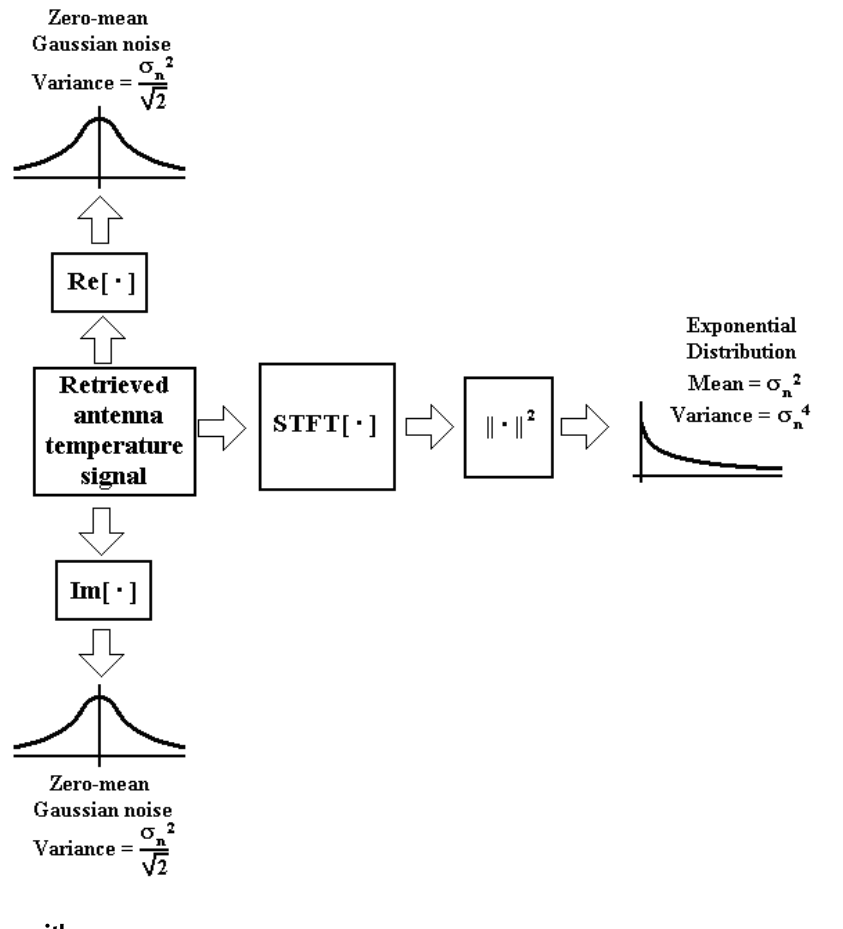
Figure 2. Transformation of the zero-mean Gaussian noise distributions (in-phase and quadrature components) into an exponential distribution with same standard deviation and